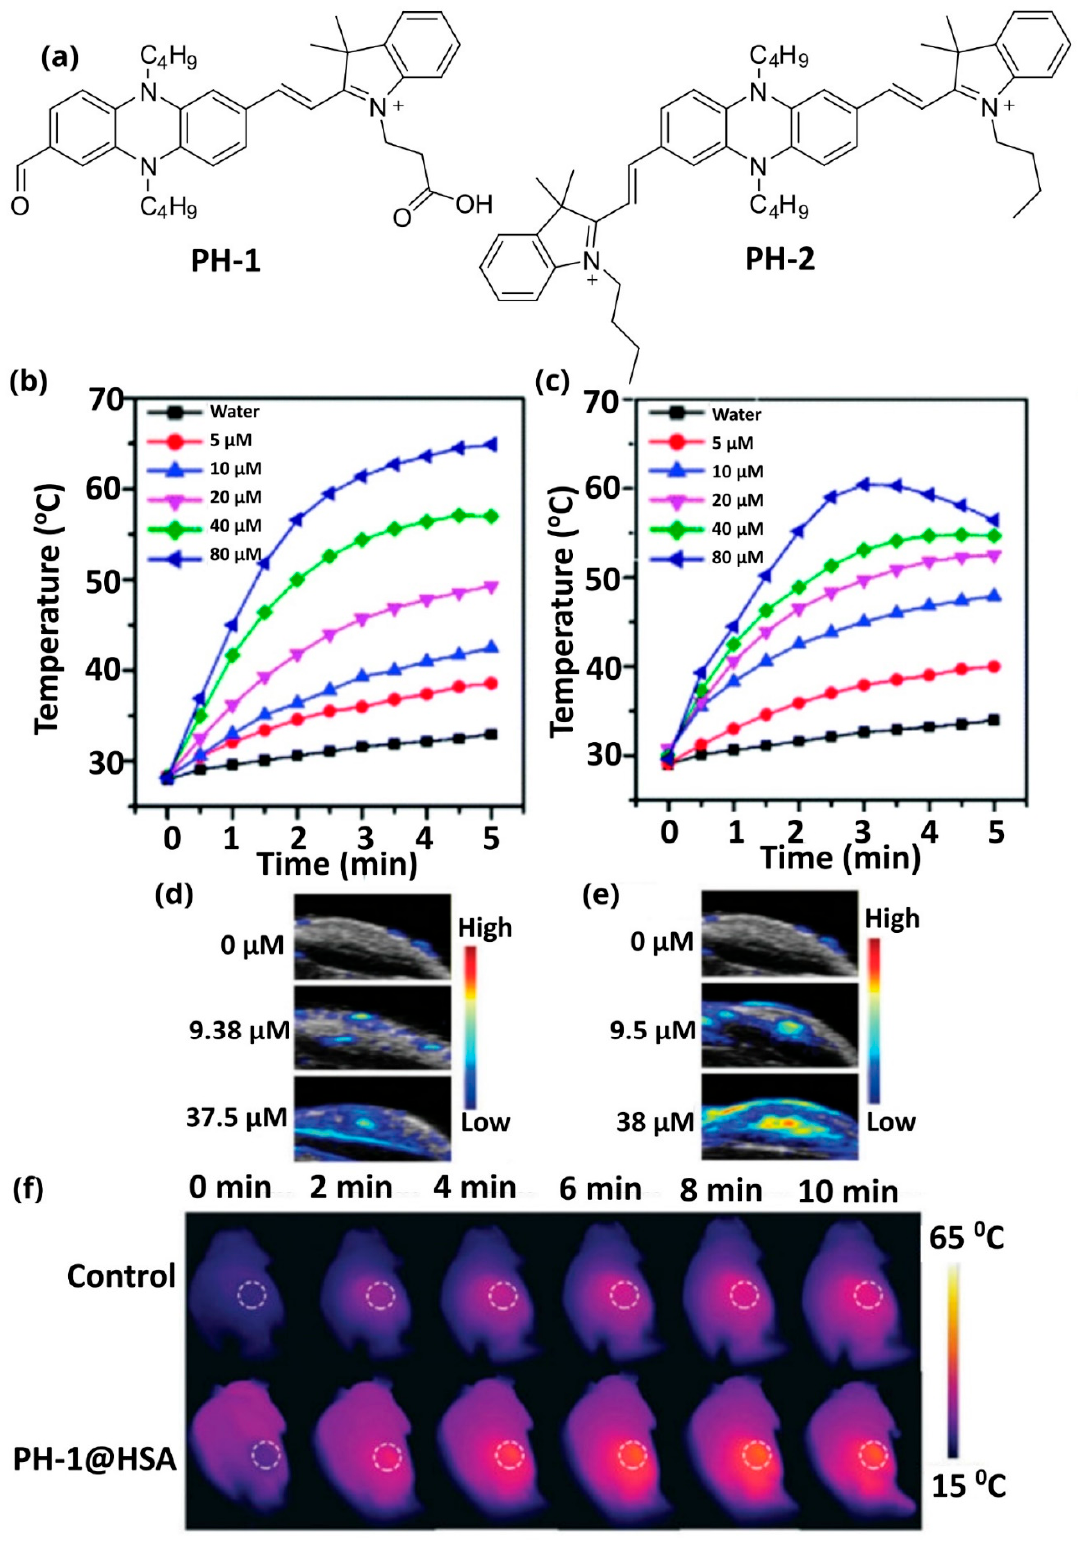
Figure 10. ( a ) Schematic diagrams of the PH-1 and PH-2 conjugates; ( b ) temperature curves of PH-1@HSA and ( c ) PH-2@HSA in different concentrations; ( d ) in vivo representation of the positive increase of the photoacoustic signal of PH-1@HSA and ( e ) PH-2@HSA in different concentrations; ( f ) thermal image of the nude mouse at different illuminating times. Adapted with permission from [122], Royal Society of Chemistry, 2018.